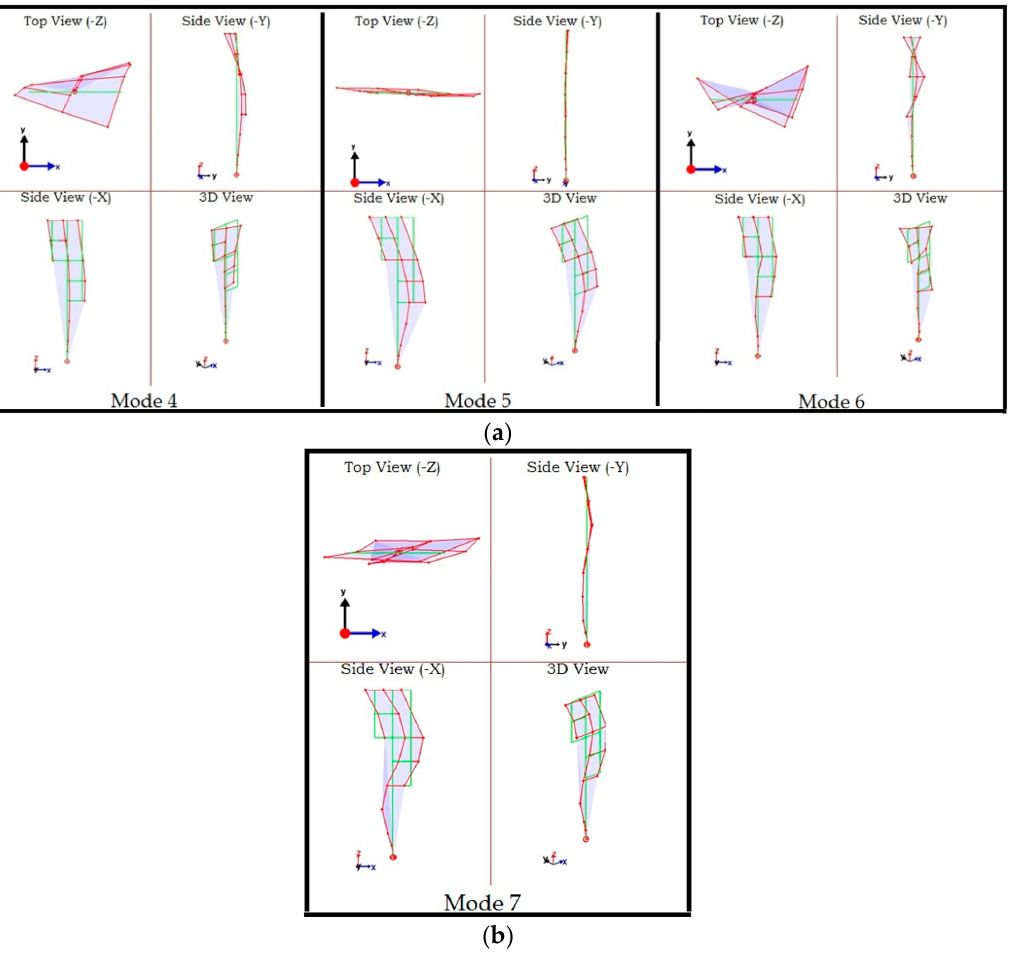
Figure 22. Additional modes after synchronization process: modes 4, 5, and 6 ( a ) and mode 7 ( b ). Although RCS and GPS time markers were used for synchronization of the data collected from the AVT of the building, it was observed that the GPS time markers are not always accurate, and that the data thus obtained can be unsynchronized. This creates a potential problem in the implementation of AVTs in large buildings such as medium- and sensors to the same DAS is not only expensive but also deteriorates the signal-to-noise ratio in the data. In extreme cases, it may simply not be possible to connect sensors from far away locations to a single